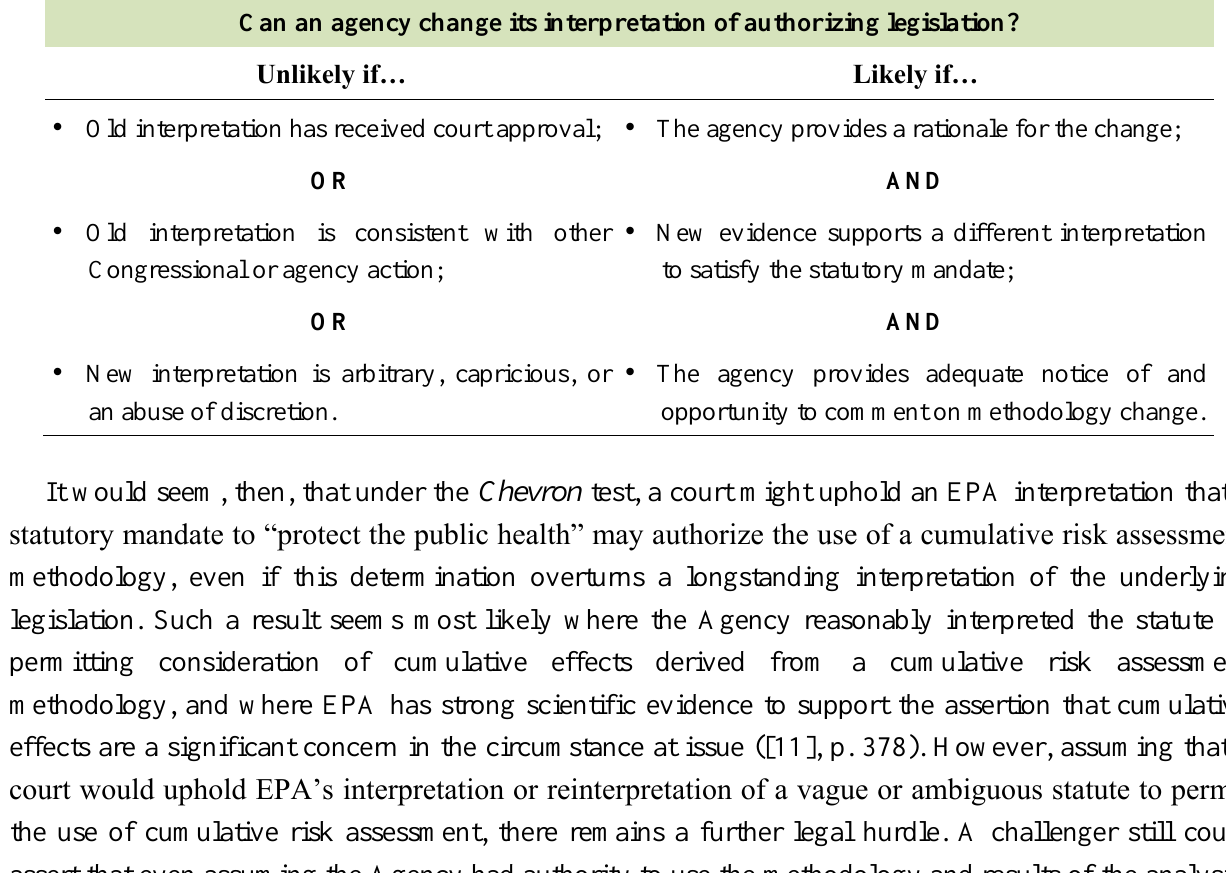
Table 1. Factors a court might consider when determining whether an agency has authority to apply a new interpretation of its authorizing